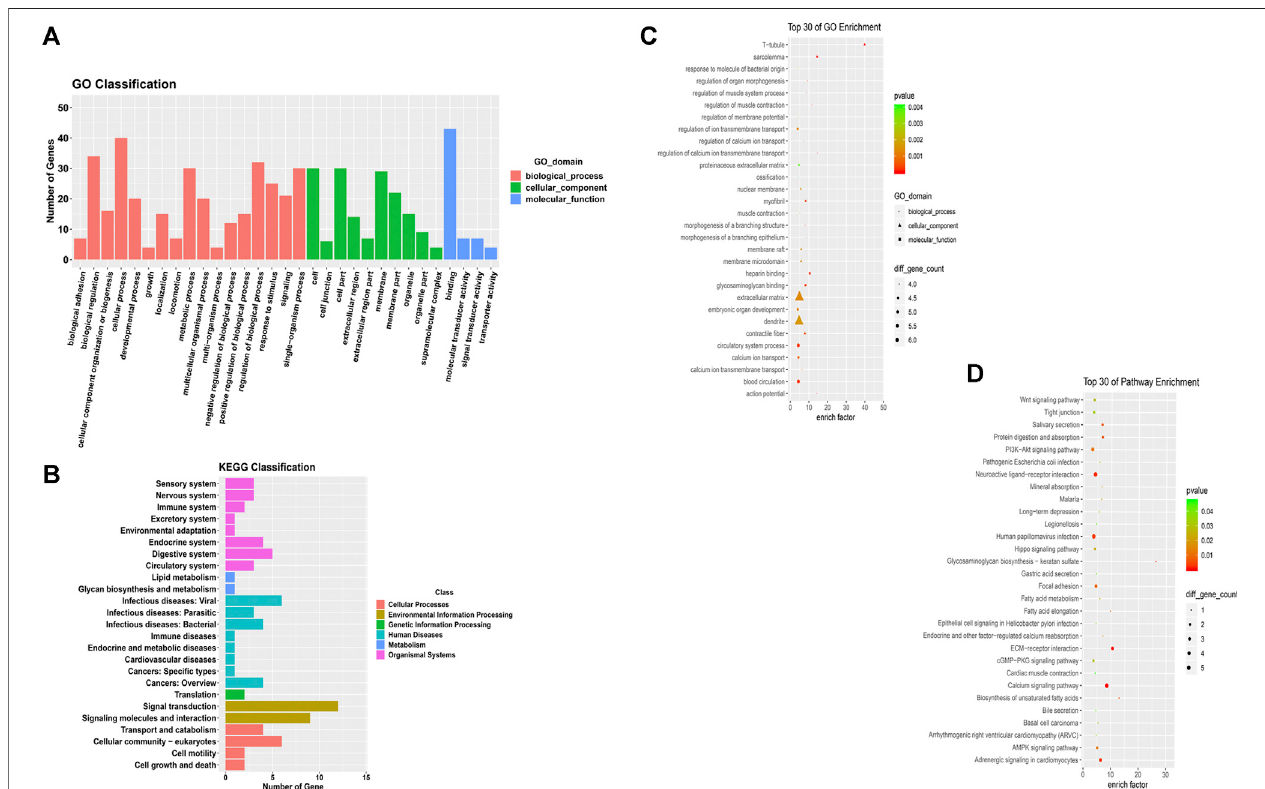
FIGURE 4 | GO functional and pathway enrichment analyses of mRNAs in the co-expression network. ( A) GO term classi fi cations for differentially expressed mRNAs (B) Top 30 GO terms in the BP, CC and MF categories for differentially expressed mRNAs. (C) KEGG classi fi cations for differentially expressed mRNAs (D) Top 30 enriched KEGG pathways for differentially expressed